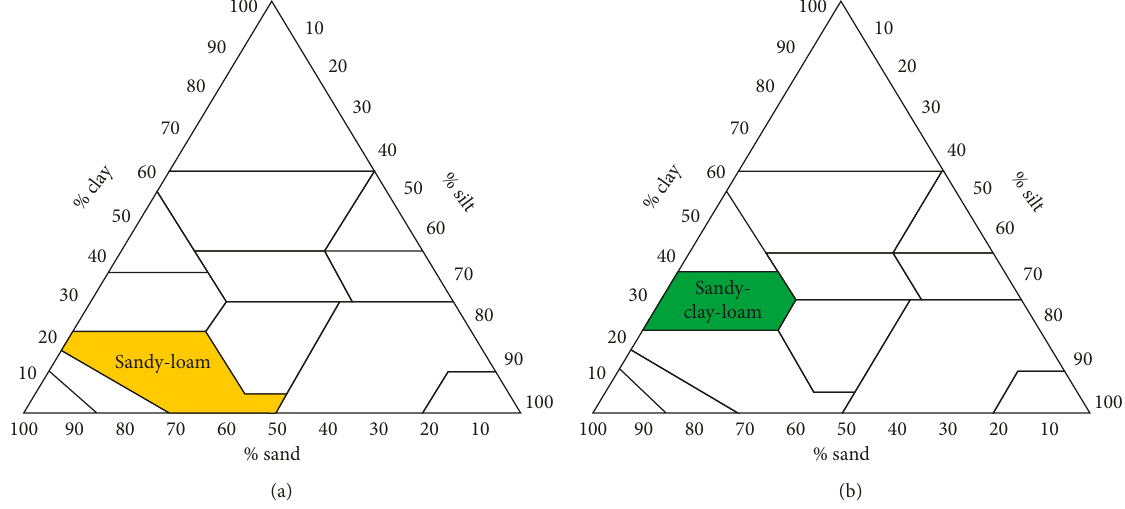
Figure 2: Soil textural classification. (a) Depth 0–0.20m. (b) Depth